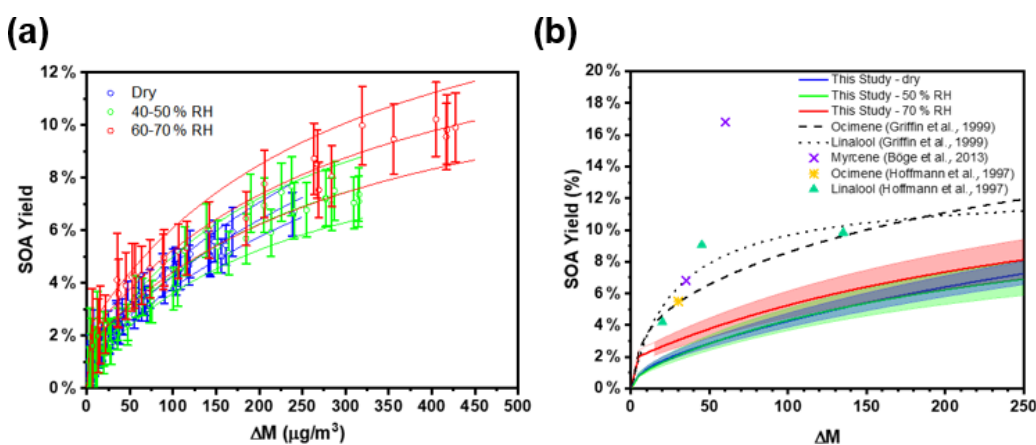
Figure 5. (a) Change in PM mass concentration ( (cid:49)M ) and secondary organic aerosol yields for seeded experiments under different RH conditions. The solid lines indicate the two-product absorptive partitioning model fit, and the dashed lines represent the 95% confidence intervals of the fitting function. (b) Two-product absorptive partitioning model fits of this study vs. model fits and SOA yield percentage reported in the literature for the acyclic tri-olefinic and oxygenated terpenes. The shaded regions represent the 95% confidence intervals of the fitting function. The fitting parameters are as follows: α 1 = 0.1768, α 2 = 0.0139, k 1 = 0.0020, and k 2 = 0.1698.